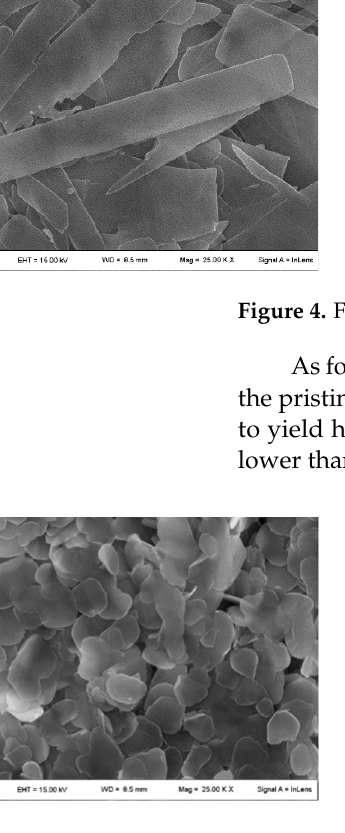
and 22.2 ppm, which are characteristic of the two crystallographically distinct phosphonate groups present in the